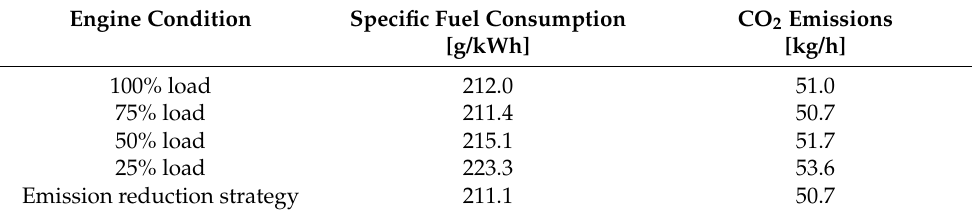
Table 4. CO 2 emissions on